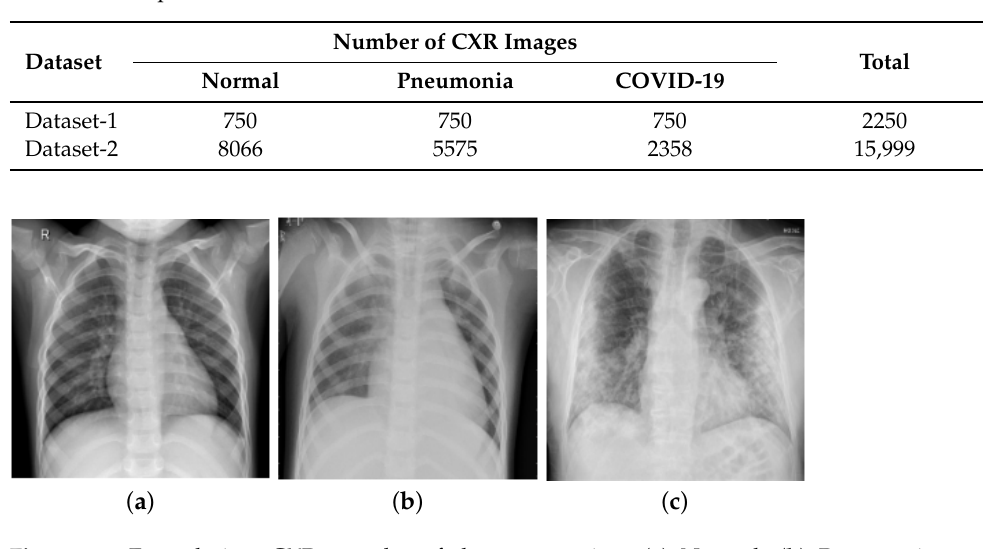
Figure 1. Frontal-view CXR samples of three categories: ( a ) Normal, ( b ) Pneumonia, and ( c )